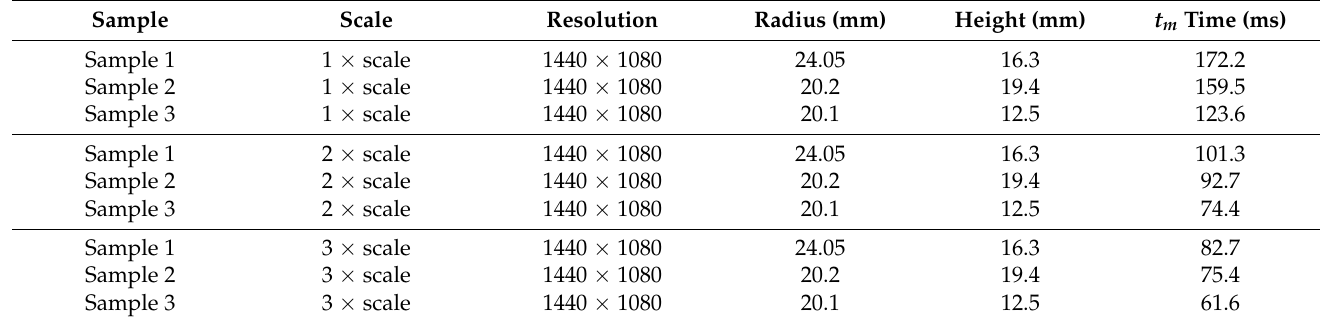
Table 1. The average unfolding and stitching time t m for 1.6-megapixel color cap images on different